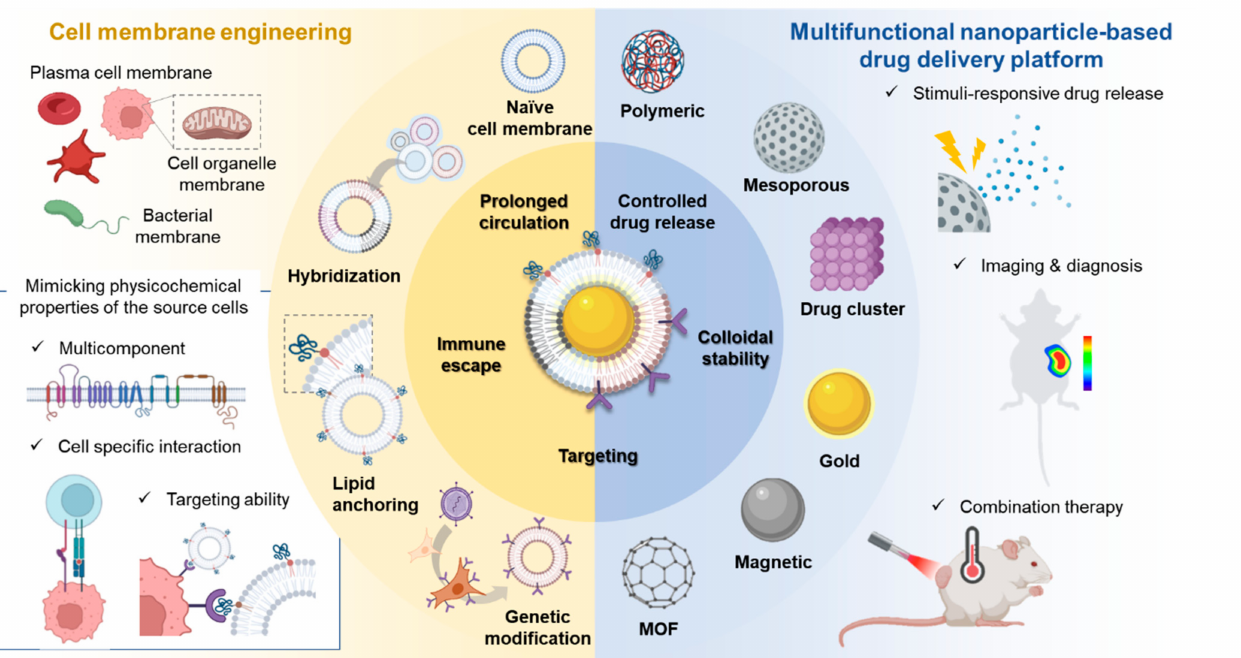
Figure 1. Schematic overview of cell membrane-cloaked nanotherapeutics for targeted drug delivery. ( Left ) plasma cell membranes, cell organelle membranes, bacterial membranes are often used as a coating material for nanoparticles to mimic physicochemical properties of source cells, for example, multicomponent, cell-specific interaction, and targeting ability. Recent advances in cell membrane engineering (e.g., hybridization, lipid anchoring, and genetic modification) allow cell membrane- based nanotherapeutics to achieve even more diverse and improved targeting effects along with prolonged circulation and immune escape. ( Right ) various nanoparticles including polymeric, mesoporous, drug cluster, gold, magnetic, and metal-organic framework are used as a core for cell membrane-based nanotherapeutics. Multifunctional nanoparticle-based drug delivery platforms allow stimuli-responsive drug release, imaging, diagnosis, and combination therapy in biomedical field. Figure created with